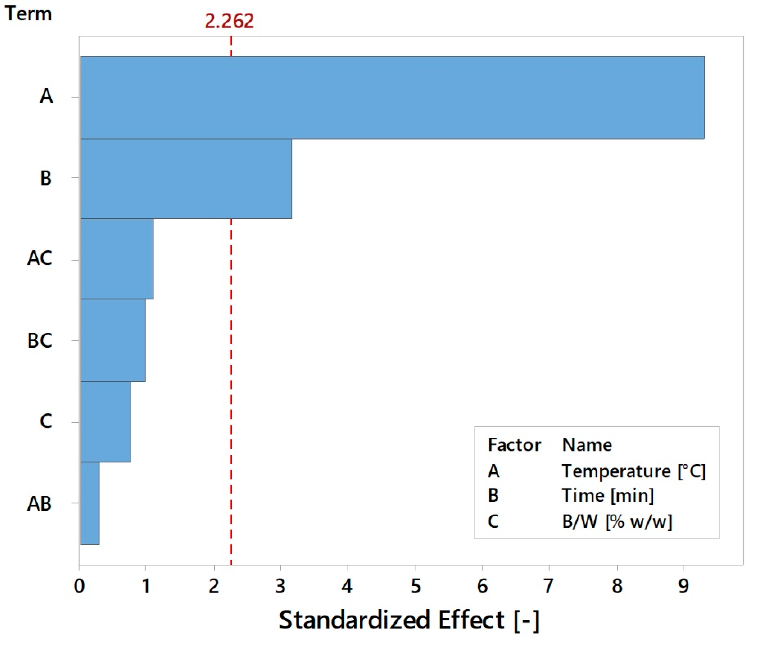
Figure 5. A normal plot of the standardized effects for BC1 yield.